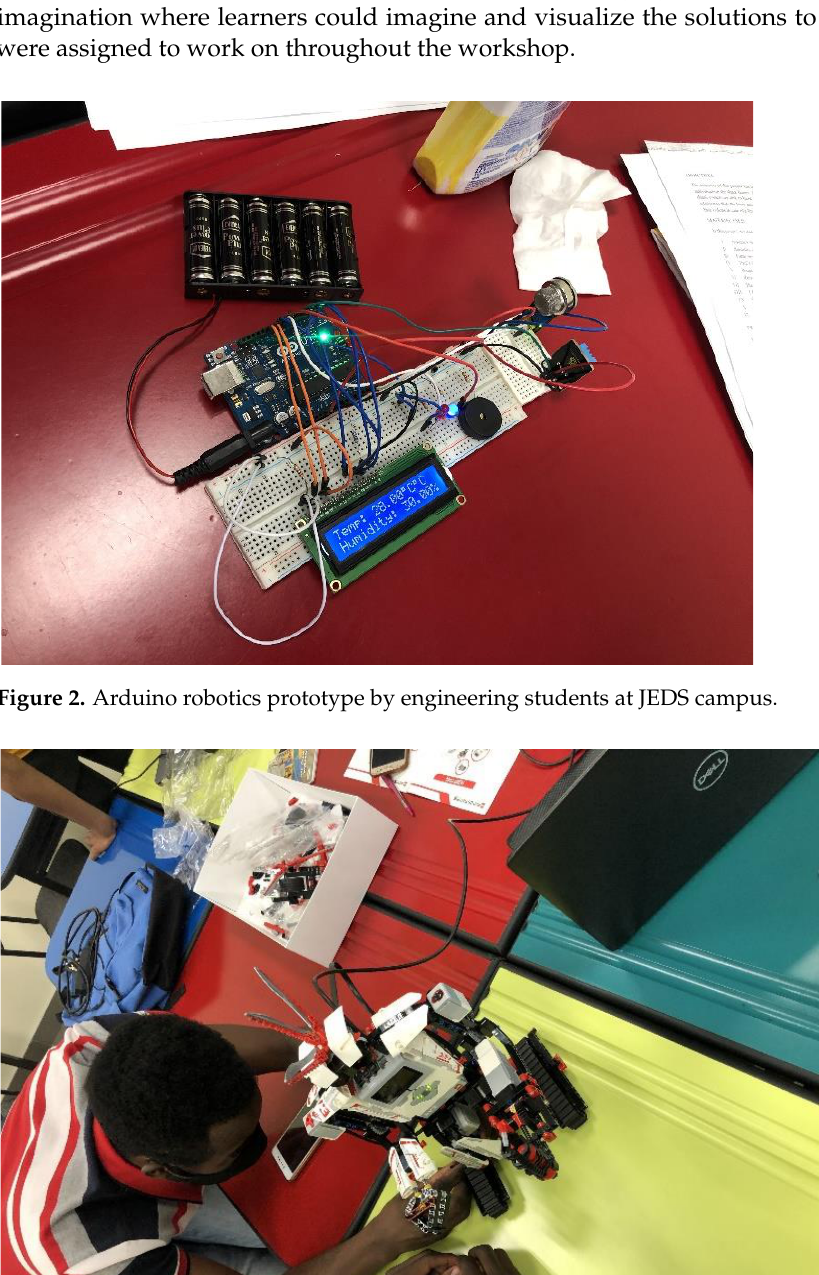
Figure 3. LEGO robotics prototype by engineering students at JEDS campus.